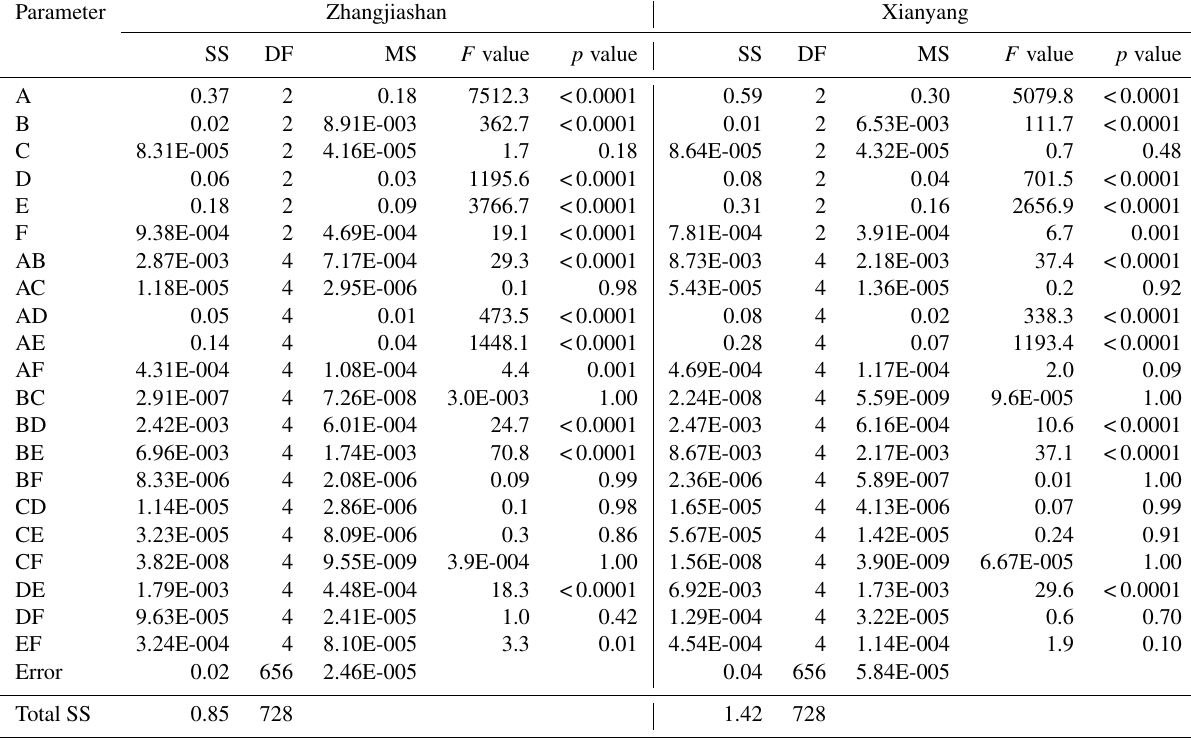
Table 4. ANOVA table for failure probability in AND: A indicates the shape parameter in GEV, B indicates the scale parameter of GEV, C indicates the location parameter of GEV, D means the meanlog of LN, E means the sdlog of LN, and F means the parameter (i.e. theta) in